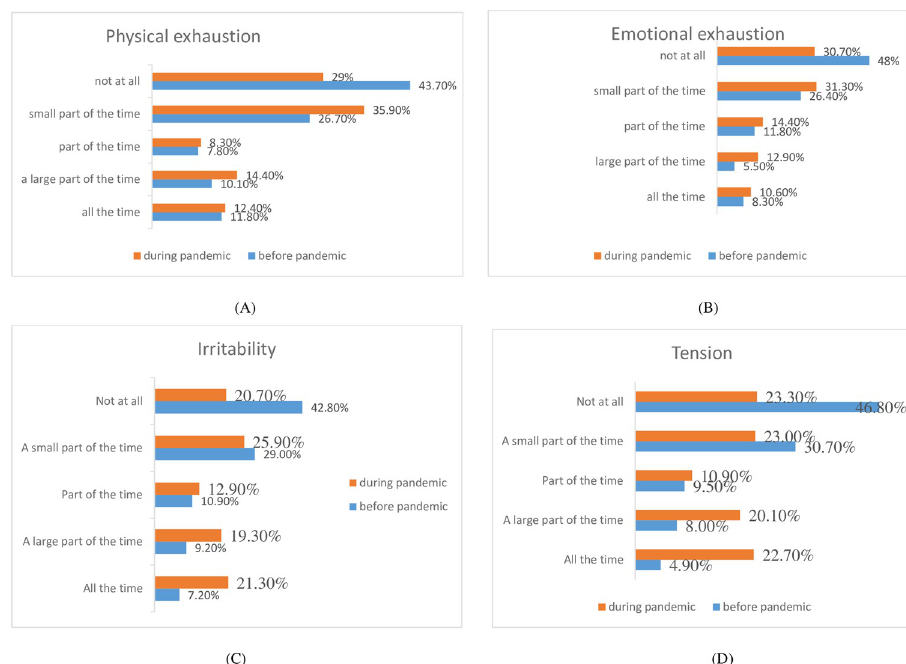
Fig 1. Stress and irritability pre-and during COVID-19 pandemic (A) Physical exhaustion; (B) motional exhaustion; (C) Irritability; (D) Tension.